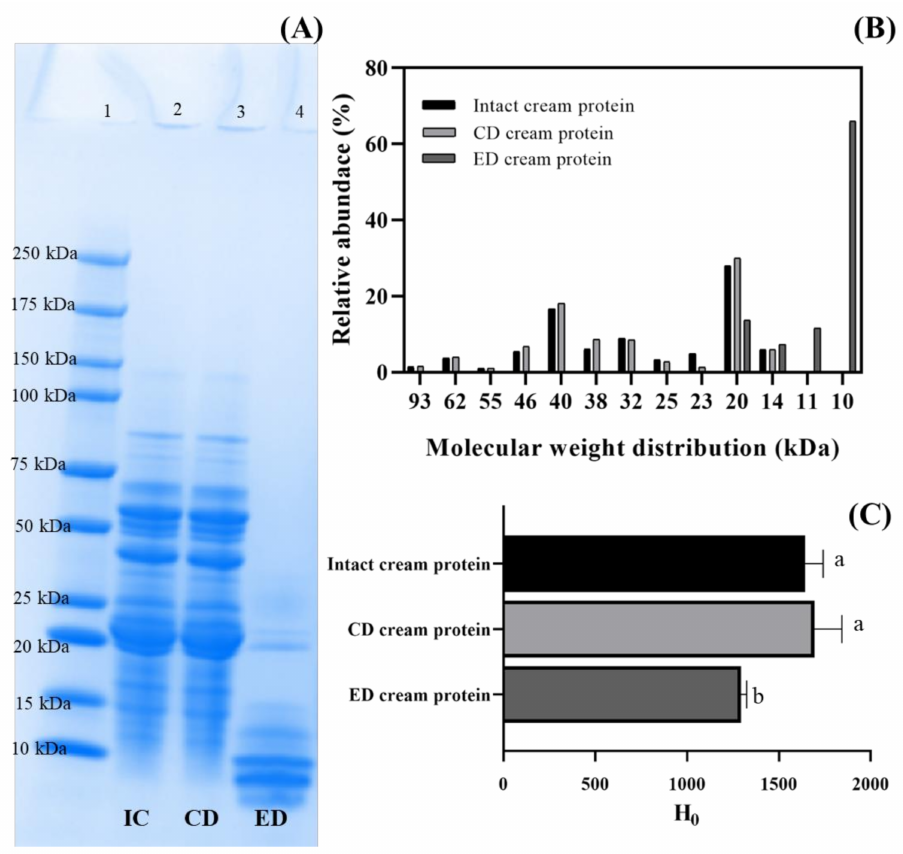
Figure 4. sodium dodecyl sulfate-polyacrylamide gel electrophoresis (SDS-PAGE) of cream proteins ( A ), Lane 1: molecular weight standard (10–250 kDa), Lane 2: intact cream (IC) protein, Lane 3: